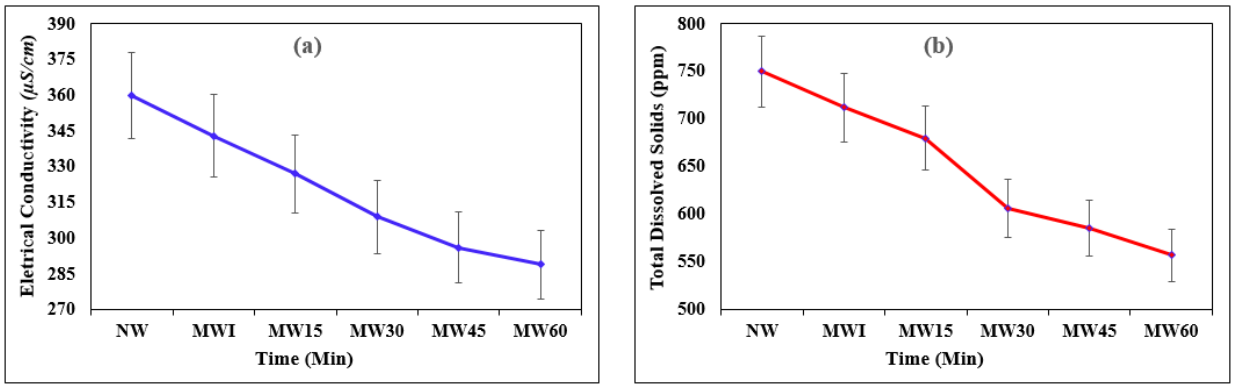
Figure 3. ( a ) Variation in EC and ( b ) TDS of NW and MW with exposure time.